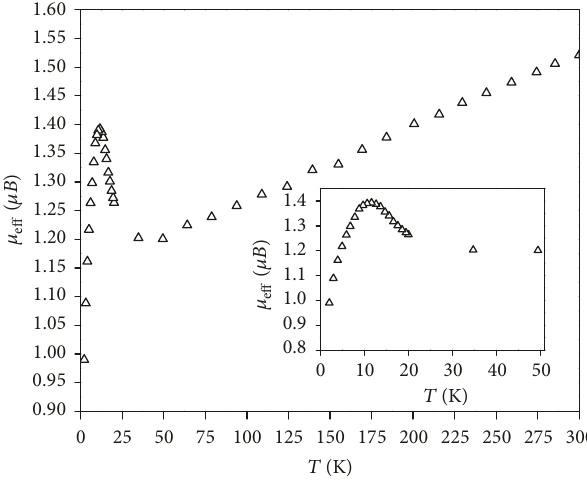
Figure 7: Effective magnetic moment ( 𝜇 magnetic field of 1000